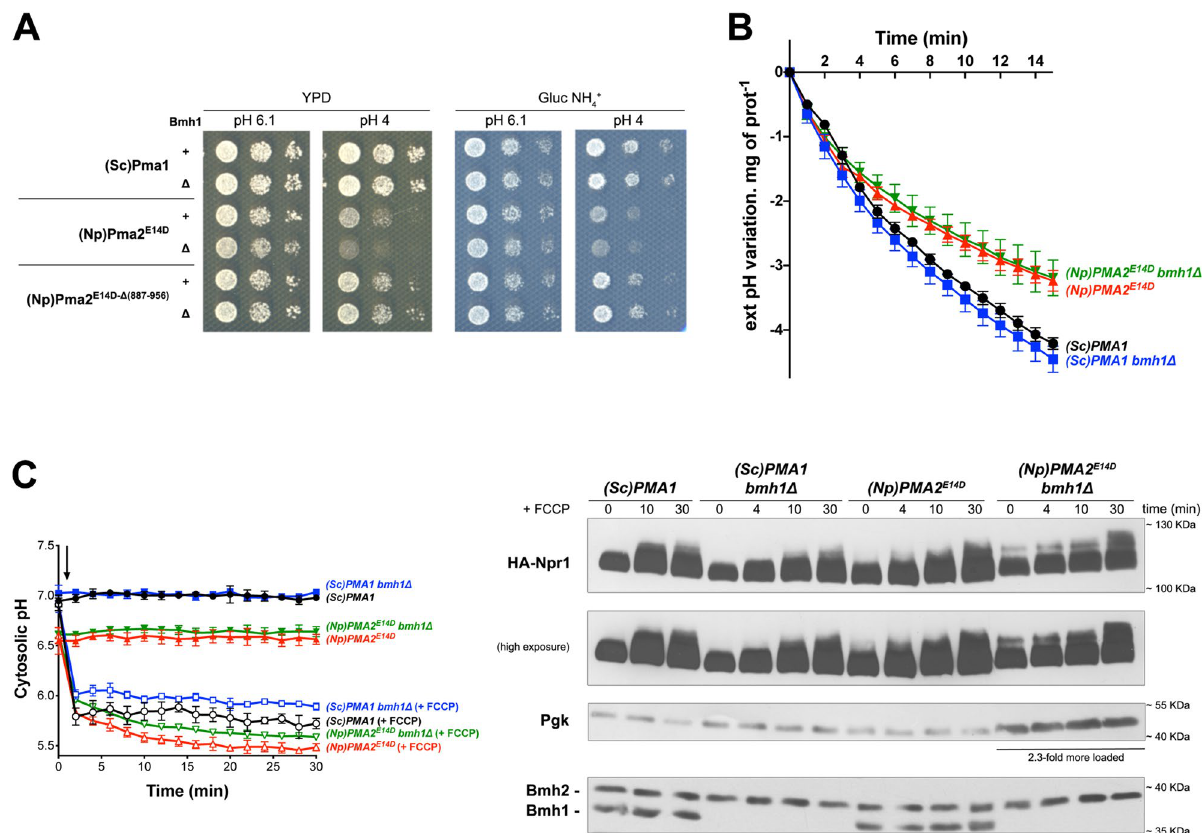
Figure 5. Reduced expression of 14–3–3 s impedes PMA2-mediated TORC1 activation. ( A ) GAL1p-PMA1 pma2Δ or GAL1p-PMA1 pma2Δ bmh1Δ cells expressing from a plasmid either (Sc)Pma1, (Np)PMA2 E14D , or (Np)PMA2 E14D-Δ(887–956) were spotted in two-fold serial dilutions on solid rich (YPD) or Gluc NH 4 + (pH 6.1 or 4) medium and incubated for three days. Similar results were obtained with the same strains additionally expressing HA-Npr1. ( B ) GAL1p-PMA1 pma2Δ or GAL1p-PMA1 pma2Δ bmh1Δ cells expressing, from plasmids, either (Sc)Pma1 or (Np)PMA2 E14D along with HA-NPR1 were grown on Gluc NH 4 + medium. Acidification by these cells of the external medium was measured as described in Materials and Methods. Average values of three biological replicates are shown, and error bars correspond to SD. ( C ) Left. Strains and growth conditions as in B, except that the cells expressed pHluorin instead of HA-Npr1from a plasmid. After a shift to Gluc proline medium for four hours, the cytosolic pH was monitored with (open symbols) or without (filled symbols) addition of FCCP (20 µM), starting at 1 min (indicated by an arrow on the graph). Average values of three biological replicates are shown, and error bars correspond to SD. Right. Strains, growth conditions, and FCCP treatment as in B, except that the cells expressed HA-NPR1 instead of pHluorin. Cells were collected before and 4, 10, and 30 min after addition of FCCP (20 µM). Crude extracts were prepared and immunoblotted with anti-HA and anti-Pgk antibodies. For samples of cells expressing (Np)PMA2 E14D , 2.3-fold more cell extract was loaded to compensate for the lower expression of HA-Npr1 which was systematically observed in independent transformed clones, for unclear reasons. On a separate gel, all samples were equally loaded and immunoblotted with anti-14–3-3. Original blots are presented in Fig. medium 34 , PMA2 E14D was found associated with both Bmh1 and Bmh2, and this interaction was abolished by the T955A substitution and by deletion of the last 70 residues. Interaction of PMA2 E14D with Bmh proteins was also strongly weakened by the T931D, T931A, and S938D substitutions. In contrast, the S938A substitution did not reduce binding to 14–3–3 s and rather tended to reinforce it (Fig. 4D), as previously reported 22 . We also analyzed cells expressing the endogenous Pma1 and found no detectable interaction with any Bmh protein (Fig. 4D). We next compared TORC1 activation by FCCP in cells expressing PMA2 E14D or PMA2 E14D-T955A . The ini- tial cytosolic pH in these cells was similar and rapidly dropped upon FCCP addition, as expected (Fig. 4E). In PMA2 E14D control cells, FCCP elicited the expected increase in HA-Npr1 phosphorylation. This response was reduced in PMA2 E14D-T955A cells, especially in the early minutes after FCCP addition, although a slight TORC1 activation remained detectable. The T955A substitution, preventing binding of 14–3–3 s and favoring self-inhibition 25 , thus impedes TORC1 activation upon H + influx. In cells expressing PMA2 E14D with a T931A or T931D substitution, acidification of the cytosol upon FCCP addition did not elicit a marked increase in HA- Npr1 phosphorylation, except after 30 min of treatment. This shows that these PMA2 E14D mutants largely fail to promote early TORC1 stimulation upon H + influx (Fig. 4F). The same TORC1 stimulation defect was observed in cells expressing PMA2 E14D with the S938D substitution, but not when S938 was replaced with Ala (Fig. 4G).